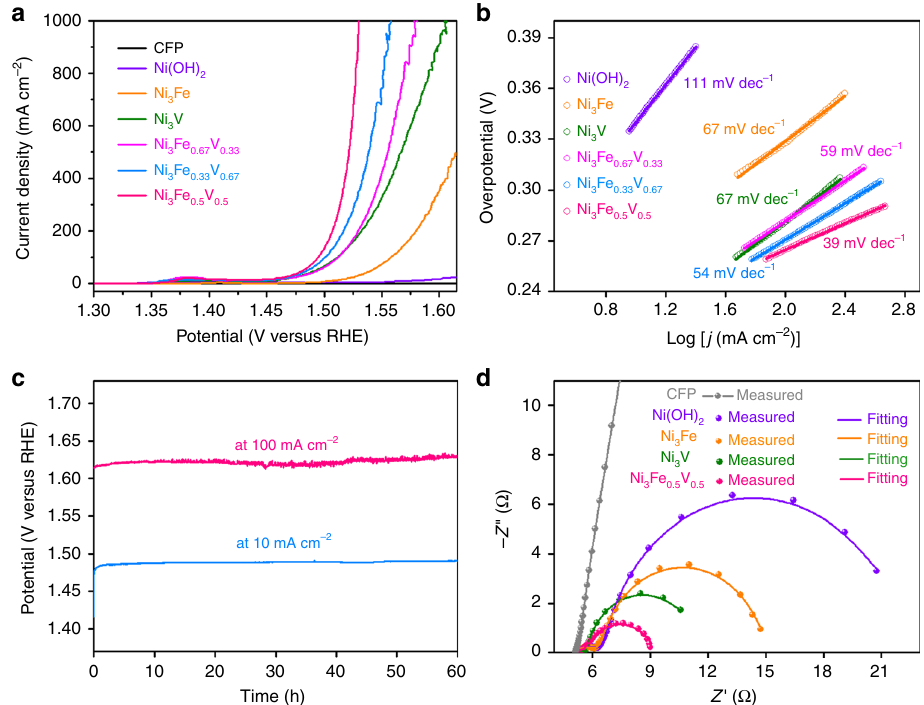
Fig. 5 Electrochemical tests for OER and Nyquist plots of the Ni-based (oxy)hydroxide catalysts. a LSV curves of Ni 3 Fe 1 − x V x and pure Ni (oxy) hydroxide catalysts on CFP, as well as bare CFP in O 2 -saturated 1 M KOH at a scan rate of 5 mV s − 1 . b Tafel plots derived from the polarization curves in a . c Chronopotentiometric curves obtained with Ni 3 Fe 0.5 V 0.5 at constant current densities of 10 and 100 mA cm − 2 . d Nyquist plots of Ni 3 Fe 0.5 V 0.5 , Ni 3 Fe, Ni 3 V, and Ni (oxy)hydroxides and the bare CFP at 300 mV overpotential in 1 M (oxy)hydroxide catalysts show the Ni 2 + /Ni 3 + oxidation in the potential range of 1.33 – 1.42 V (all potentials are versus reversible hydrogen electrode (RHE)) 5,7,43 .